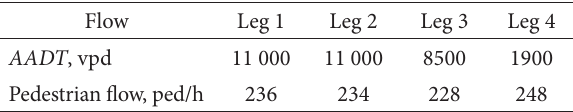
Table 8. Traffic and pedestrian flows at the intersection under investigation